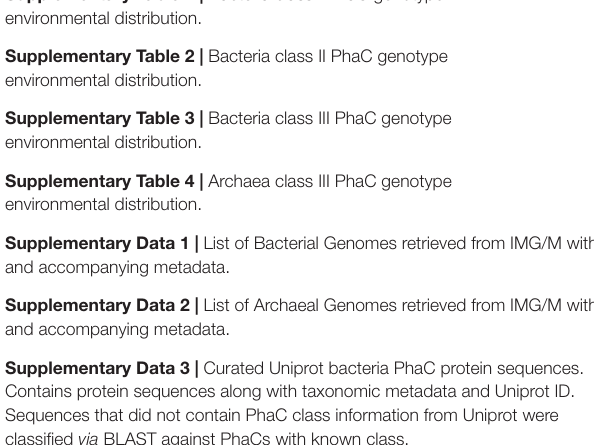
Supplementary Table 1 | Bacteria class I PhaC genotype environmental distribution. Supplementary Table 2 | Bacteria class II PhaC genotype environmental distribution. Supplementary Table 3 | Bacteria class III PhaC genotype environmental distribution. Supplementary Table 4 | Archaea class III PhaC genotype environmental